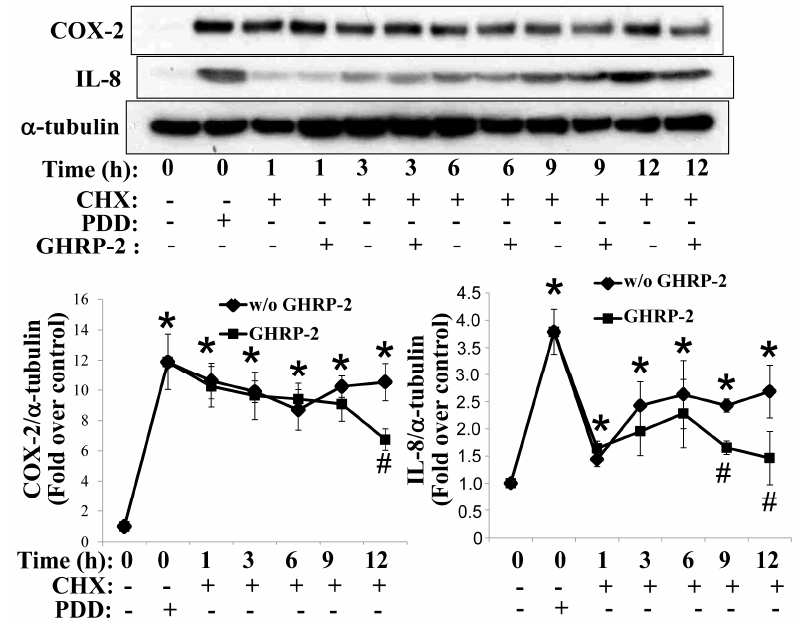
Figure 3. Promotion of the degradation of PKC-induced COX-2 and IL-8 proteins by GHRP-2. Plated KGN cells were either untreated or treated with PDD (100 nM) for 6 h to induce COX-2 and IL-8 protein expression (defined as 0 h), and then the cells were treated with cycloheximide (CHX, 5 µg/mL) or CHX in combination with GHRP-2 (1 µM) for 1, 3, 6, 9, and 12 h. The intracellular COX-2 and IL-8 protein expression levels were determined by Western blotting assay. The results represent the means ± SEM ( n = 4) * p < 0.05 compared with the control; # p < 0.05 compared between with GHRP-2 and without GHRP-2 groups.